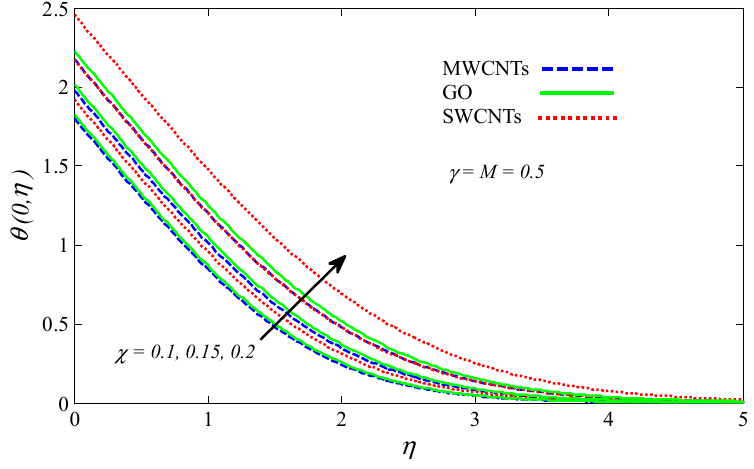
Figure 2. Impact of χ on θ .